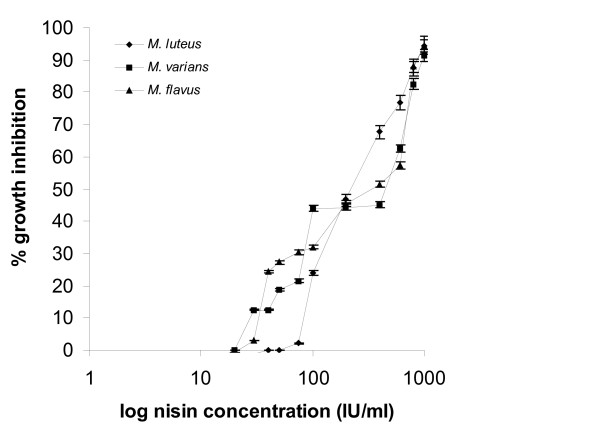
log10 nisin concentrations vs percentage inhibition of growth by Micrococcus spp. in the turbidometric assay.